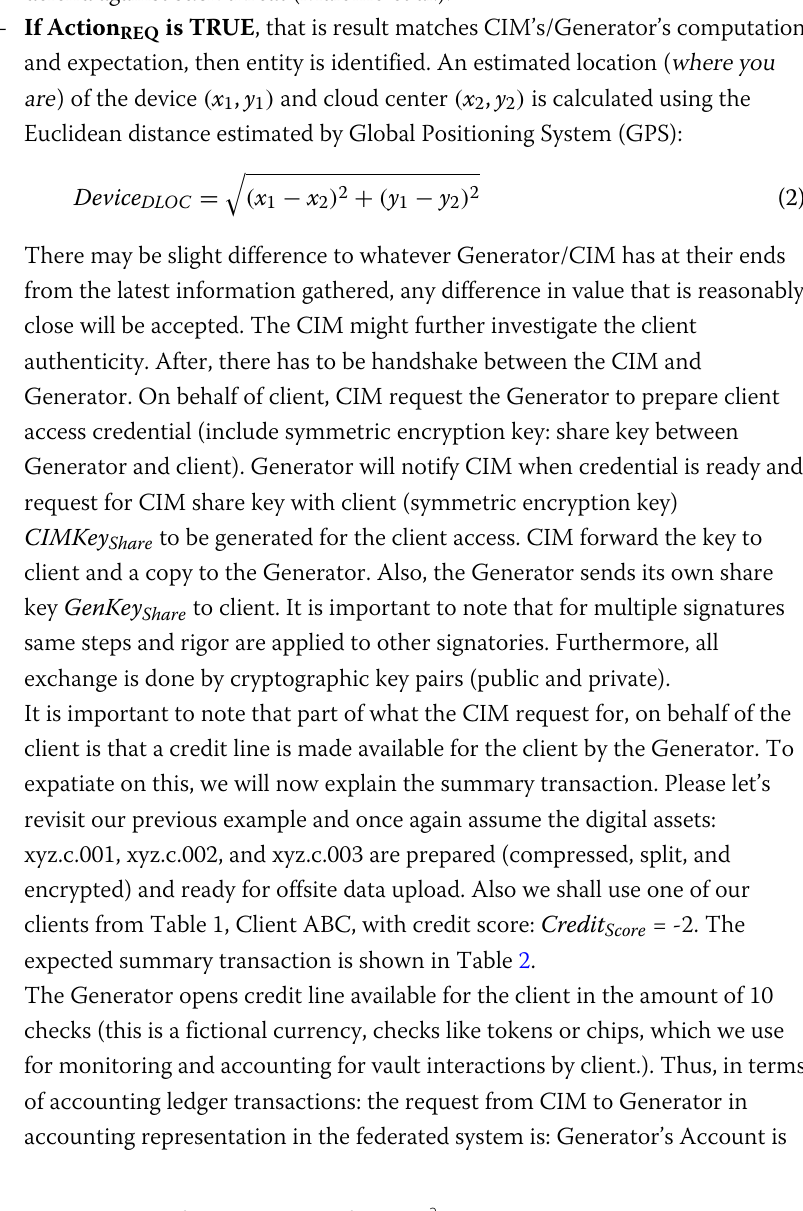
Table 2 Summary transaction for digital asset to/from BFC 2 vault CIM’s Account Client’s